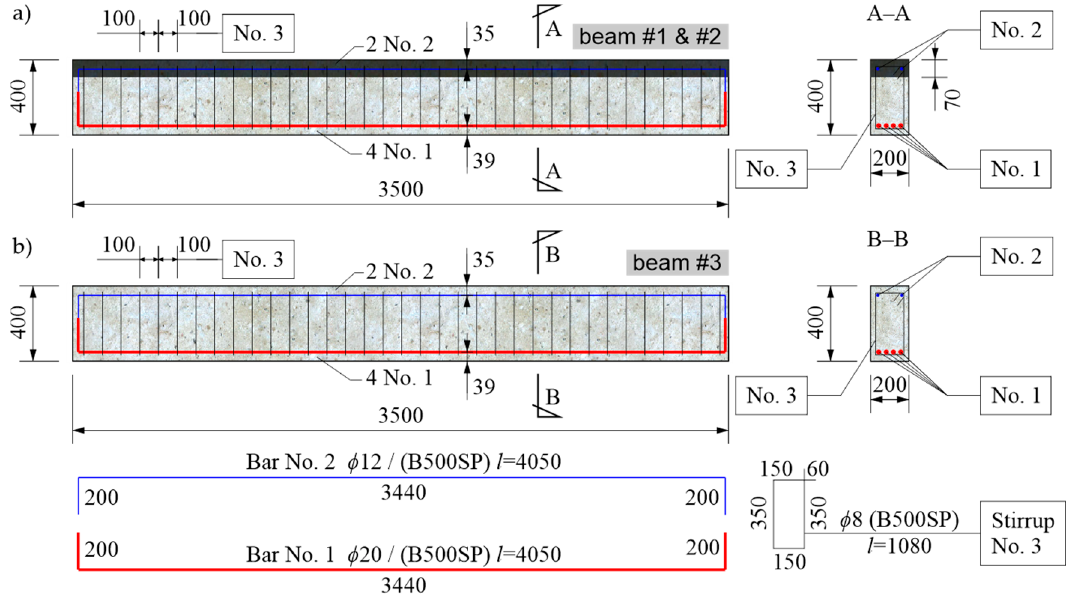
Figure 6. Side view, cross-section and reinforcement: ( a ) beams strengthened with the RPC layer, ( b ) reference beam (dimensions in mm).